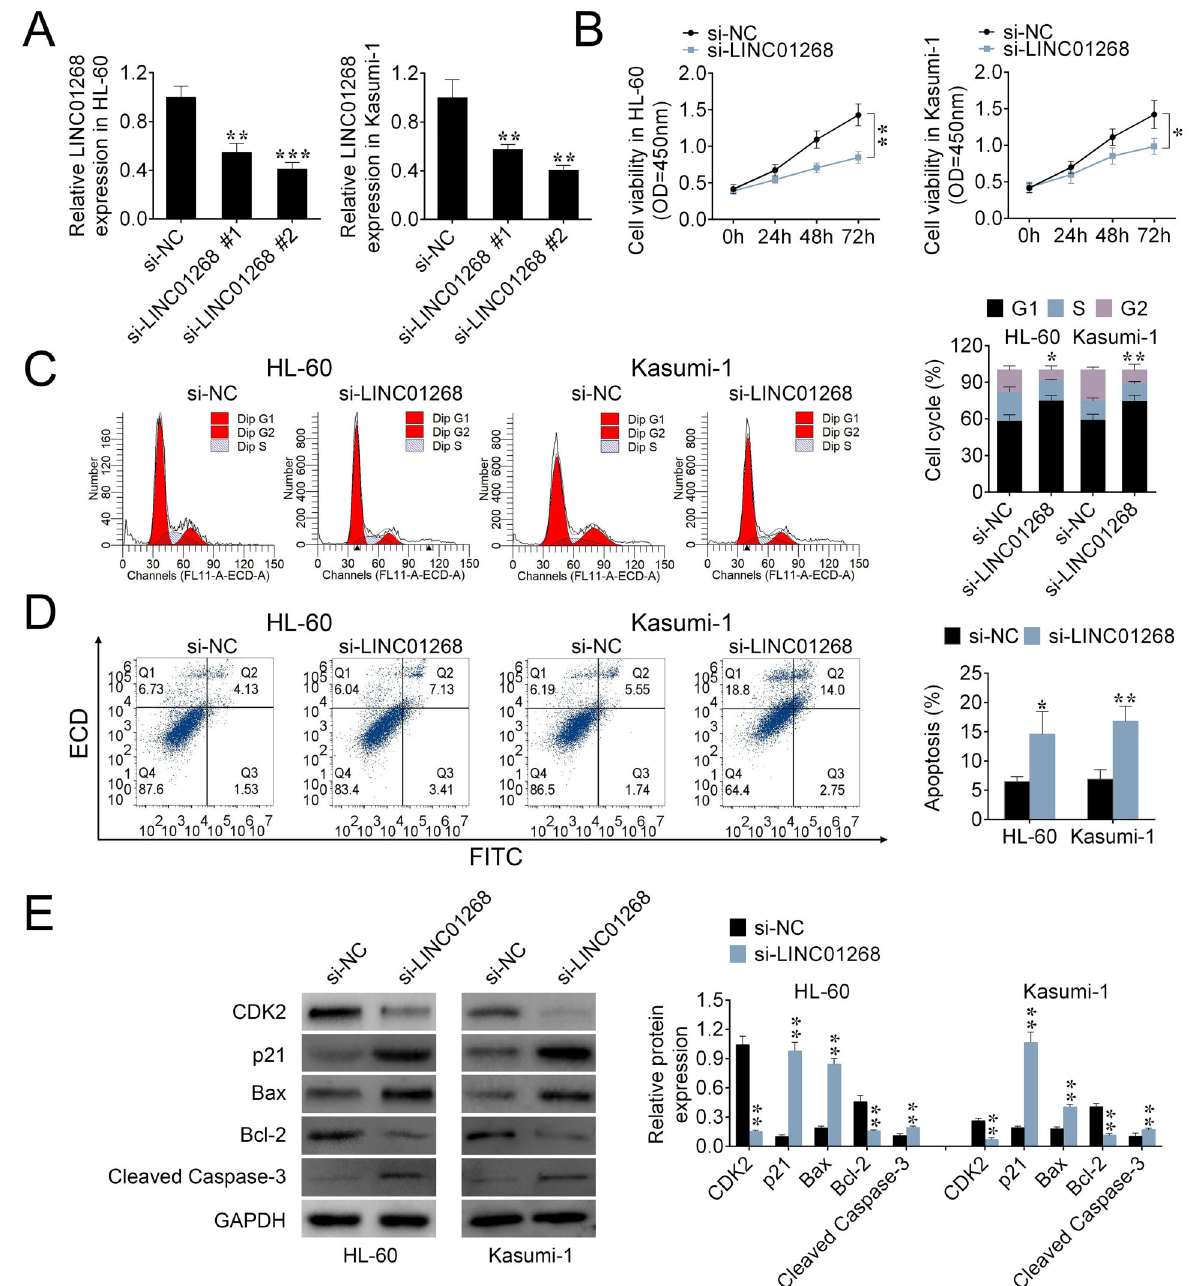
Figure 2. The effects of LINC01268 on acute myeloid leukemia (AML) cells. A , The expression of LINC01268 was detected by qRT- PCR in HL-60 and Kasumi-1 cells transfected with LINC01268 siRNAs (si-LINC01268 #1, si-LINC01268 #2). B , The viability of the transfected cells was examined by CCK-8. C and D , Cell cycle and apoptosis of the transfected cells were detected by fl ow cytometry. E , Protein expression levels of CDK2, p21, Bax, Bcl-2, and cleaved caspase-3 were determined by western blot. Data are reported as means ± SD. *P o 0.05, **P o 0.01, ***P o 0.001 vs the control group (NC) (ANOVA and t